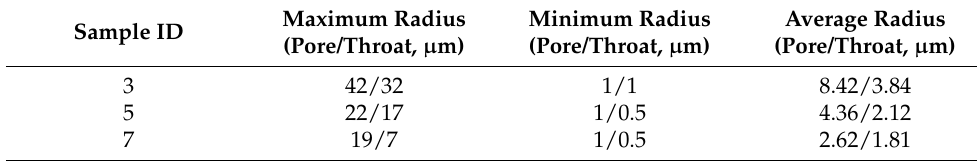
Table 5. Measurement results of contact angle of samples and single minerals.